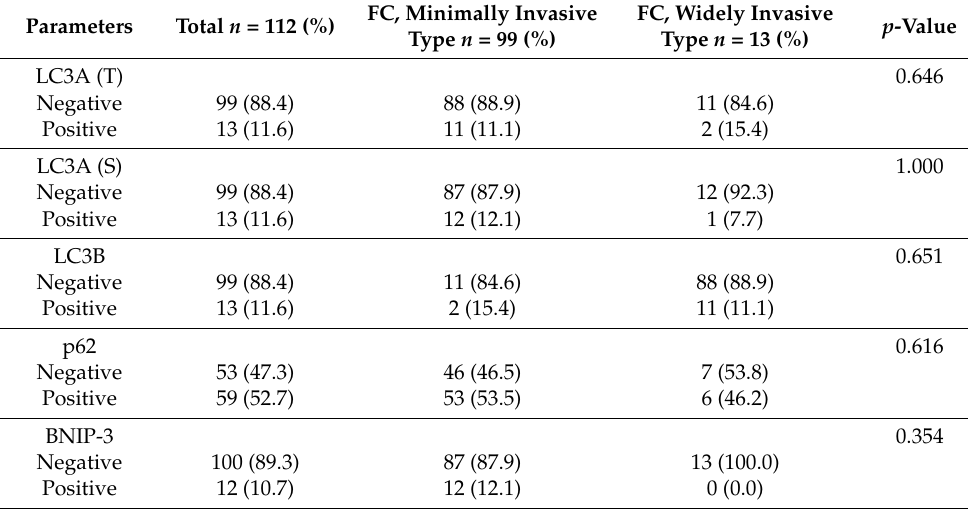
Table 4. Expression of autophagy-related proteins according to histologic follicular carcinoma (FC) subtype.